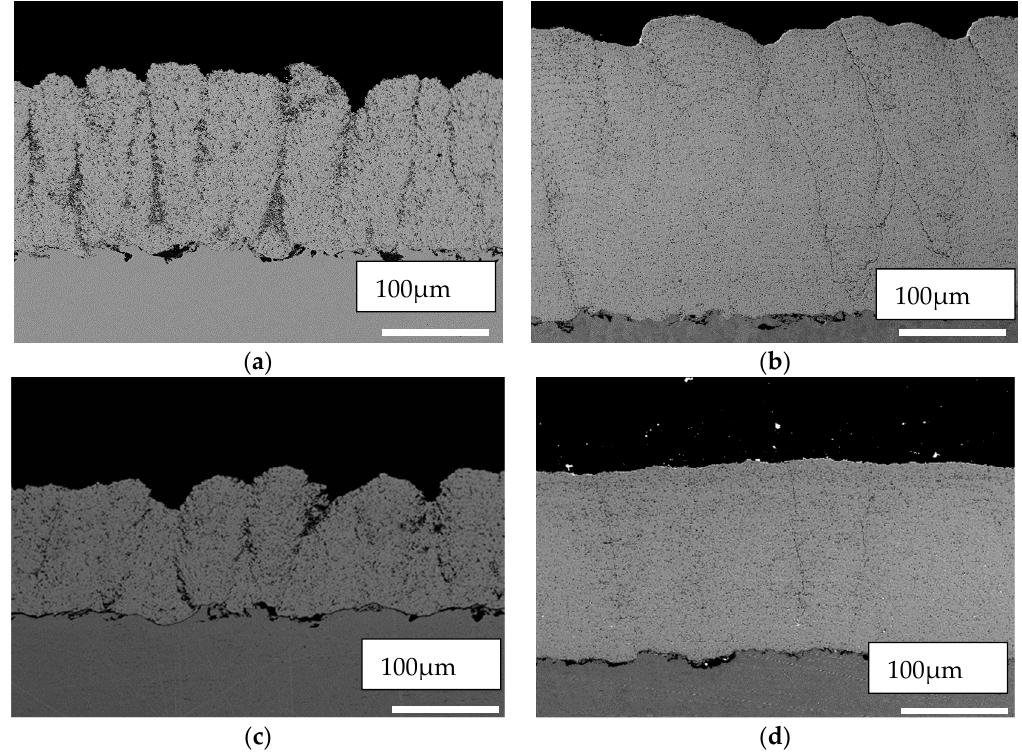
Figure 9. Backscattered SEM micrographs of the coatings deposited by axial injection using various suspensions; ( a ) C1; ( b ) C2; ( c ) HM2 and ( d ) C3.